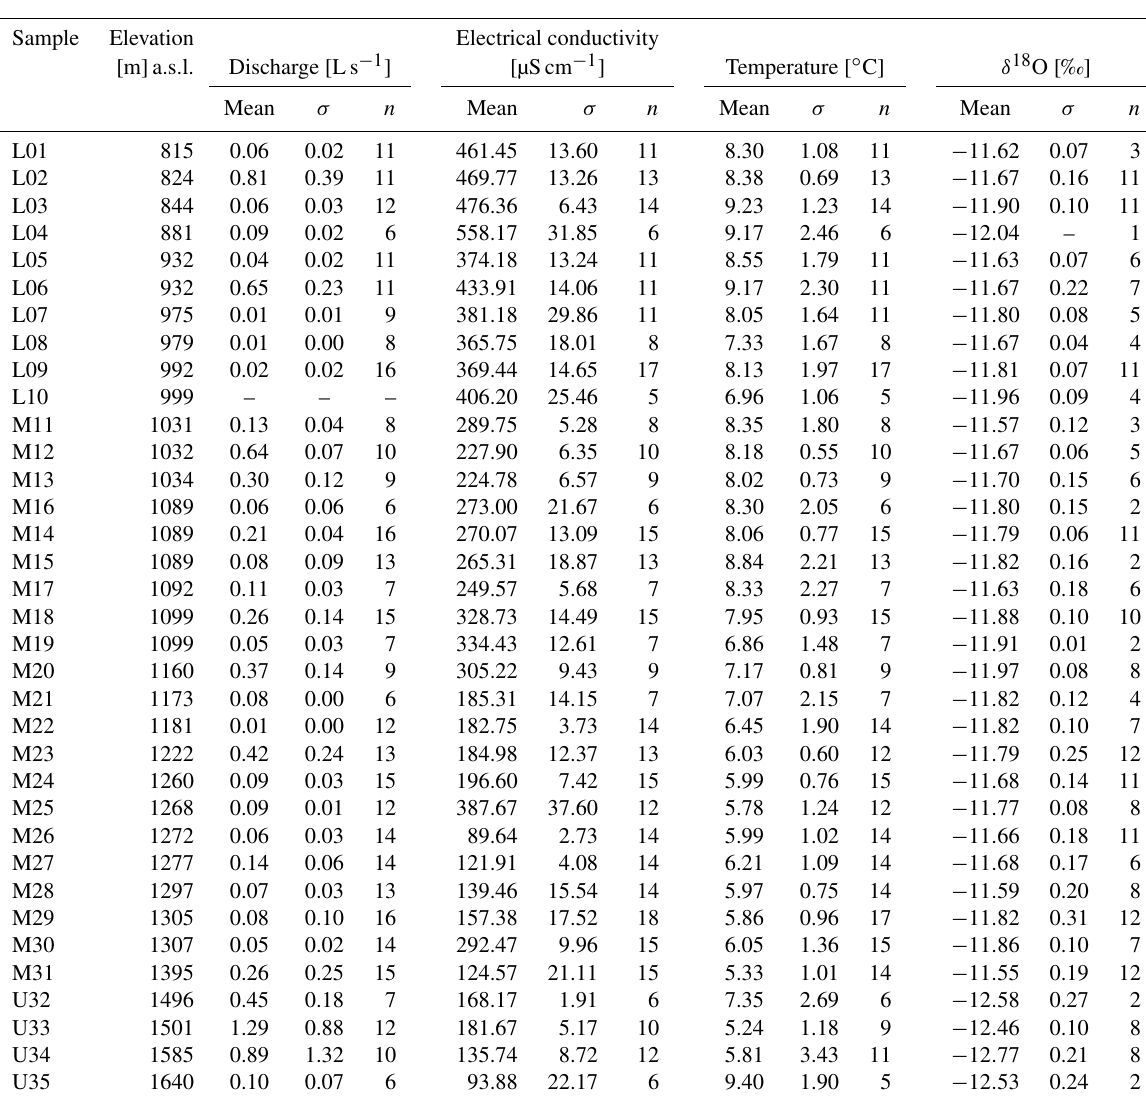
Table 2. Statistics of physico-chemical spring parameters.